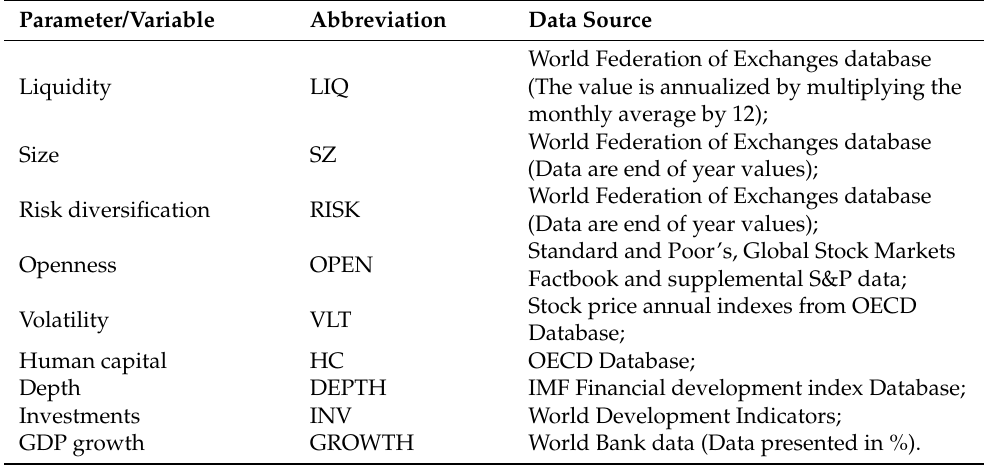
Table 1. Data sources for the parameters and control variables involved in the